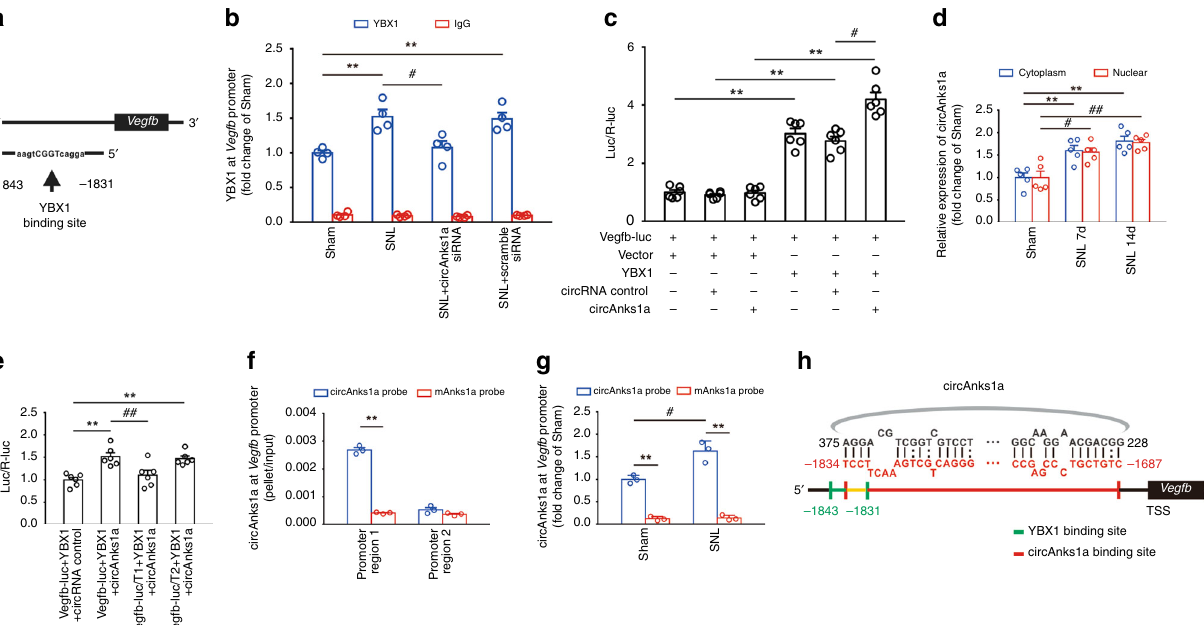
Fig. 8 CircAnks1a binding to Vegfb facilitated the recruitment of YBX1 to the Vegfb promoter. a The simulation showed a potential YBX1 binding site in the Vegfb gene promoter region at position − 1843/ − 1831. b Chromatin immunoprecipitation assays were performed using YBX1 antibody on day 14 after SNL with or without circAnks1a siRNA application (i.t.) ( ** P < 0.01 vs. sham group, # P < 0.05 vs. SNL + scramble siRNA group, two-tailed one-way ANOVA, n = 4). c YBX1 overexpression enhanced luciferase activities, while circAnks1a overexpression had no effect on luciferase activity. ( ** P < 0.01 vs. control vector, # P < 0.05 vs. circRNA control, two-tailed one-way ANOVA, n = 6). d CircAnks1a expression in the cytoplasm and nucleus was examined on days 7 and